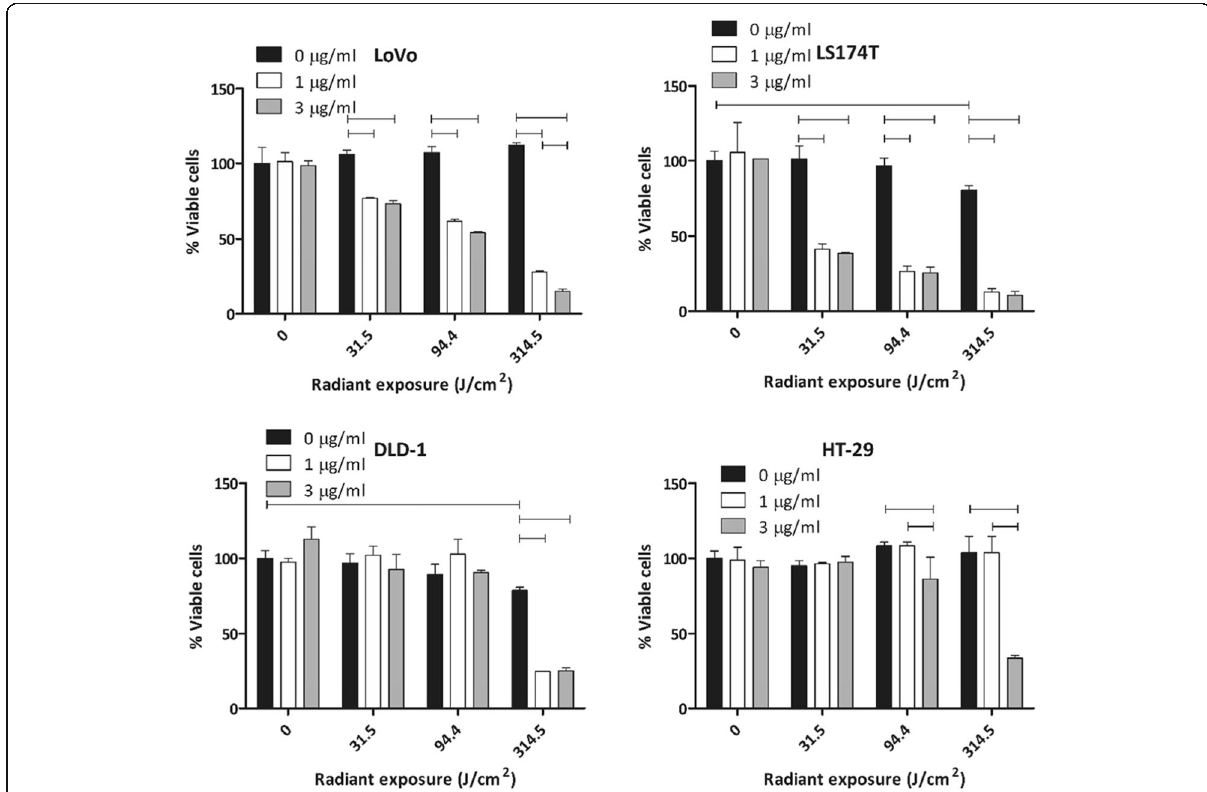
Fig. 1 In vitro cell viability (tPDT effect) on LoVo, LS174T, DLD-1, and HT-29 cells treated with different doses of light and antibody conjugate concentration. Statistically significant differences ( p < 0.05) are indicated with horizontal